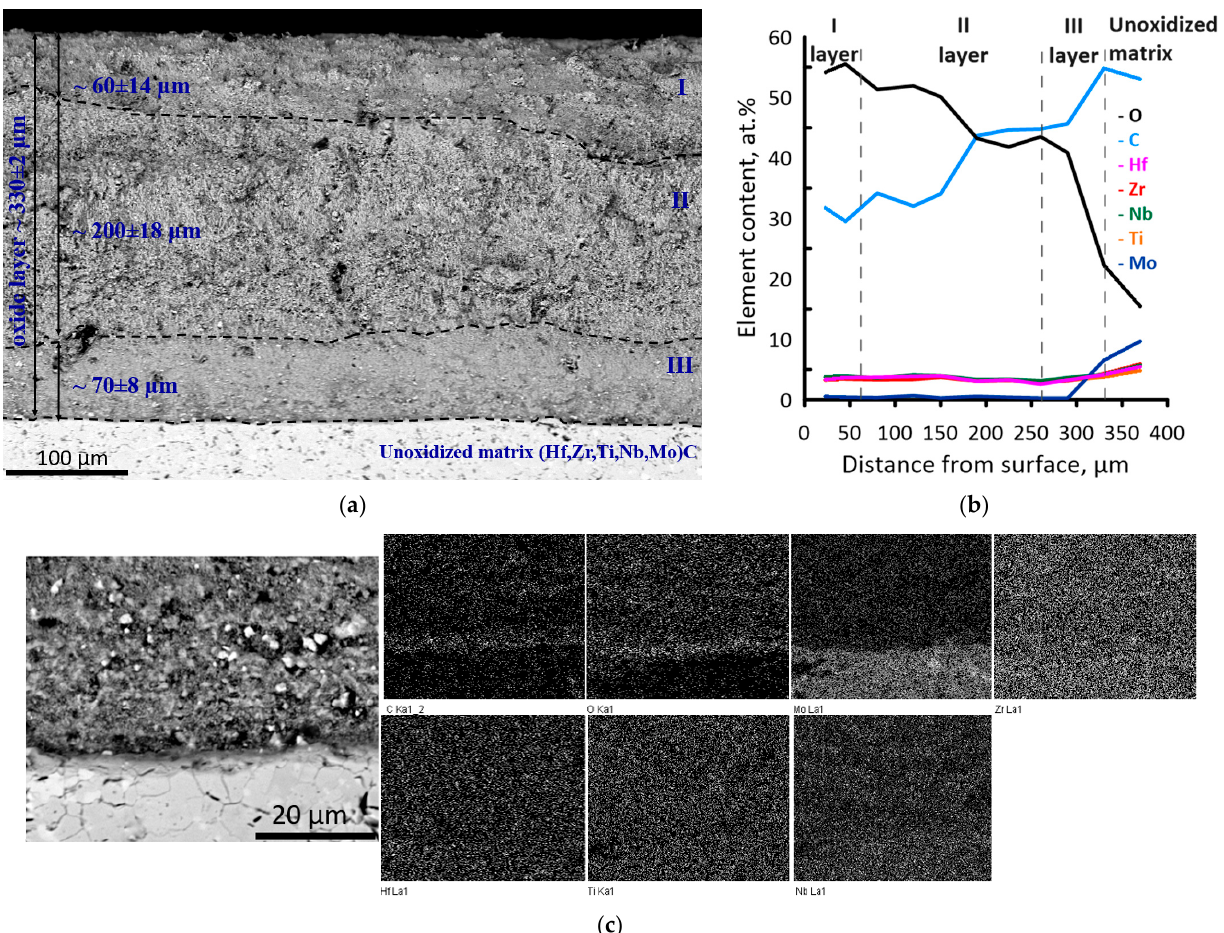
Figure 7. SEM image of ( a ) cross-section of (Hf,Zr,Ti,Nb,Mo)C ceramic after high-temperature treatment at 1200 °C; ( b ) atomic concentration of the elements on the prepared cross-section; ( c ) EDS mapping on the “matrix-oxide” interface.